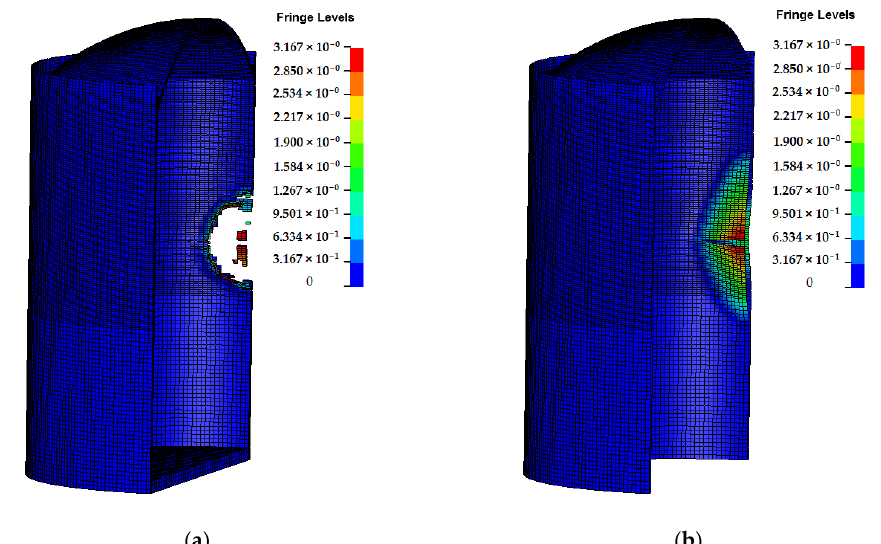
Figure 22. Contours of the maximum impact displacement and failure modes. ( a ) Concrete; ( b ) Steel plate.